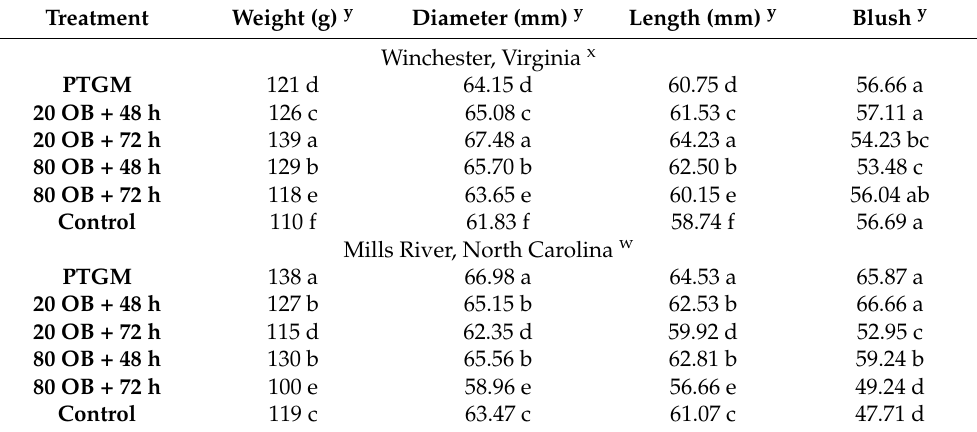
Table 5. Treatment effect on individual fruit weight, diameter, length, and blush of ‘Gala’ apples. z